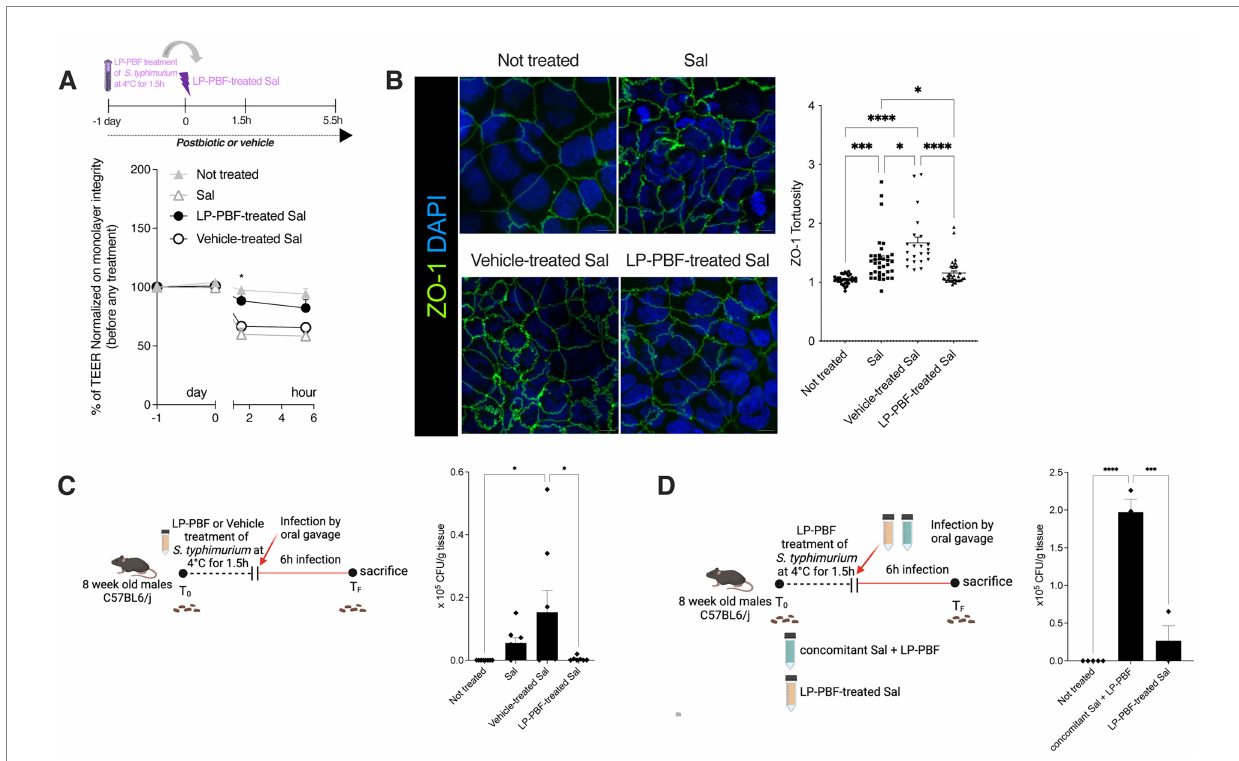
FIGURE 3 Salmonella typhimurium treated with LP-PBF is less invasive and not able to disrupt IEB. (A) TEER values of Caco-2 cells pre-treated overnight with LP-PBF, followed by infection with LP-PBF-treated S. typhimurium SL1344 (LP-PBF-treated Sal) or vehicle-treated S. typhimurium SL1344 (Vehicle- treated Sal). Infected Caco-2 cells were left for 4 h in recovery phase in the presence of postbiotic or vehicle. * Statistical analysis was evaluated using Two-way ANOVA, Tukey’s multiple comparisons test. Schematic representation of the experimental design is present above the graph. (B) Representative immunofluorescence images of ZO-1 done on Caco-2 cells after 1.5 h of LP-PBF-treated S. typhimurium infection. Graph on the right represents quantification of ZO-1 junction tortuosity—ratio between junction length and Euclidean distance between its ends. Experimental design as in A. * Statistical analysis was evaluated using One-way ANOVA, Tukey’s multiple comparisons test. (C) LP-PBF or vehicle-treated Sal dissemination in colon after 6 h of infection. On the left schematic representation of experimental design (created with Biorender). S. typhimurium SL1344 was preincubated with either postbiotic or vehicle for 1.5 h at 4°C. Following, 8-week-old C57BL6/J male mice were infected with 10 9 CFU of LP-PBF-treated or vehicle-treated Sal via oral gavage and upon 6 h were sacrificed. Fecal pellets were collected before and after infection. * Statistical analysis was evaluated using One-way ANOVA, Tukey’s multiple comparisons test. (D) Graph represent dissemination of S. typhimurium in colon after 6 h of infection with S. typhimurium SL1344 in the presence of 135 mg/kg of LP-PBF (concomitant Sal + LP-PBF) and LP-PBF-treated Sal. On the left schematic representation of experimental design (created with Biorender). S. typhimurium SL1344 was preincubated with postbiotic for 1.5 h at 4°C. Following, 8-week-old C57BL6/J male mice were infected with either 10 9 CFU of LP-PBF-treated or S. typhimurium with concomitant presence of one dose of 135 mg/kg LP-PBF and upon 6 h were sacrificed. Fecal pellets were collected before and after infection. * Statistical analysis was evaluated using One-way ANOVA, Tukey’s multiple comparisons test. * p -value < 0.05; ** p -value < 0.01; *** p -value < 0.001; **** p -value <